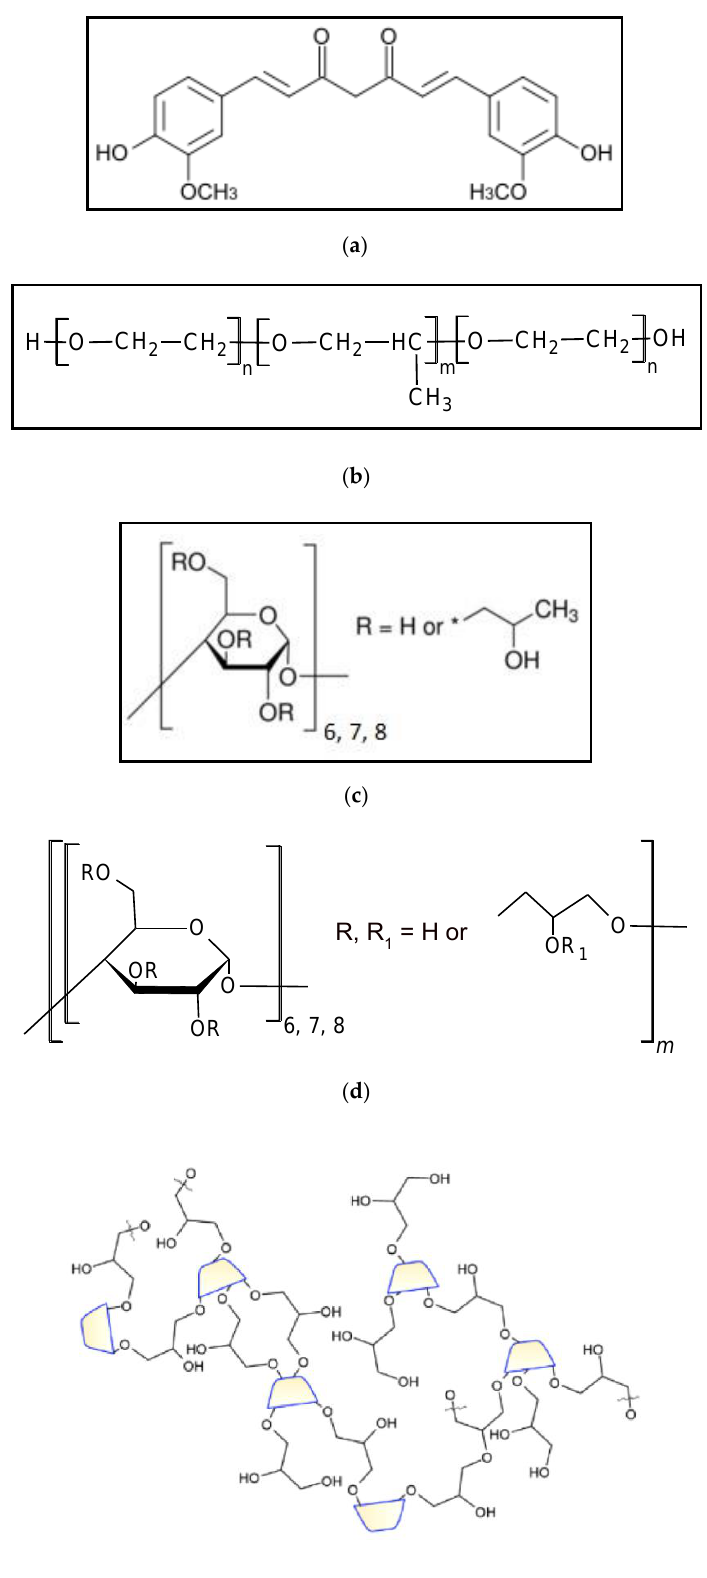
Figure 1. Chemical structure of the curcumin (keto form): ( a ) Pluronics; ( b ) hydroxypropyl-cyclodextrin derivatives; ( c ) polycyclodextrins ( d , e ) m = 110–140. Table 1. Main properties of the applied Pluronics.